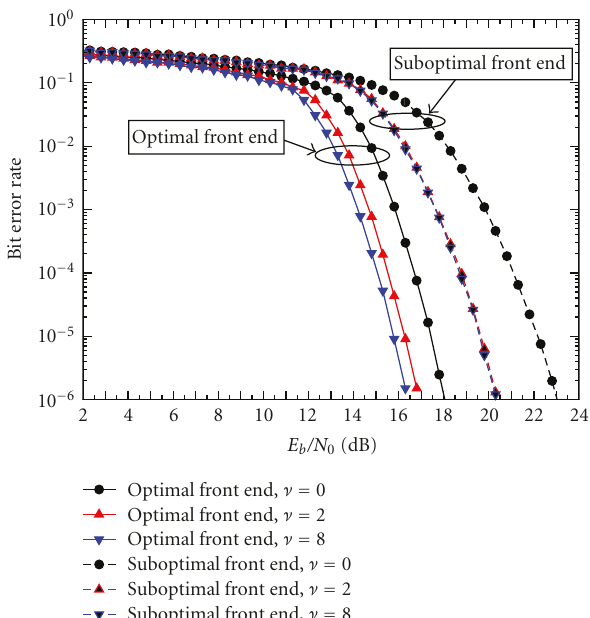
Figure 7: Performance of the proposed receivers for 4D-TCM 64 QAM and various values of prediction order, obtained with an 8- state 4D-TCM code applied to a 64 QAM constellation, signaling frequency f s = 2 . 4 MHz and carrier frequency f c = 6 MHz. The LV power line channel is modeled as in Section 4.2.